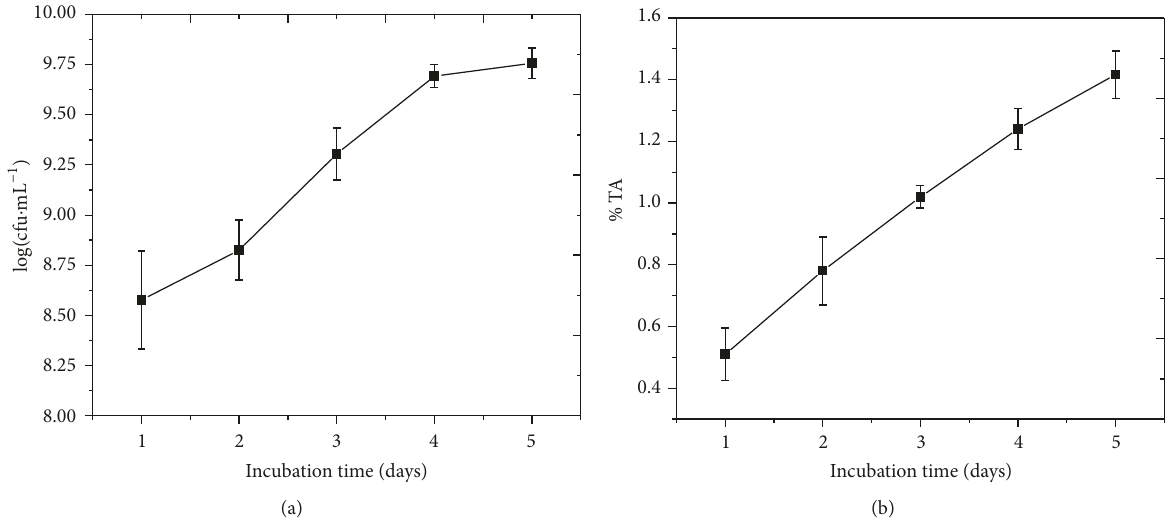
Figure 5: (a) Changes in LAB count; (b) changes in titratable acid percentage (% TA) in Ethiopian traditionally fermenting milk ( ergo ) incubated at ambient (20 to 25 ∘